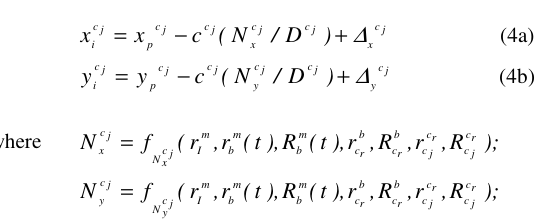
multi-camera systems. b R : is the rotation matrix relating the IMU and the rc reference camera coordinate systems; rc r : is the spatial offset between the reference jc camera ( c r ) and the j th camera perspective centers, defined relative to the reference camera coordinate system; rc R : is the rotation matrix relating the reference jc camera and the j th camera coordinate